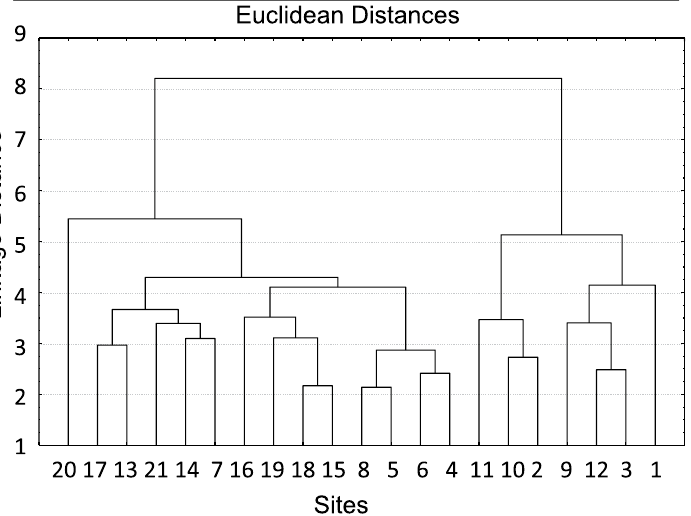
Figure 3. Dendrogram obtained from the cluster analysis of elemental concentrations using the unweighted pair-group average method. Numbers in the horizontal axis identify the 21 sampling sites indicated in Table 1. Plot generated by using STATISTICA (data analysis software system, version 7, http://www.statsoft.com/ Products/STATISTICA-Features) 38 .